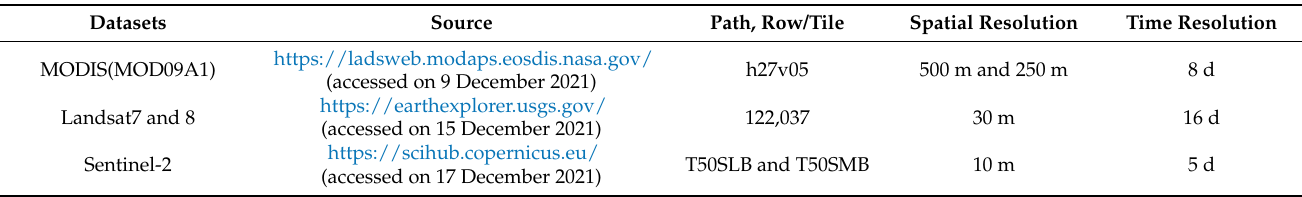
Table 1. Information of satellite data.